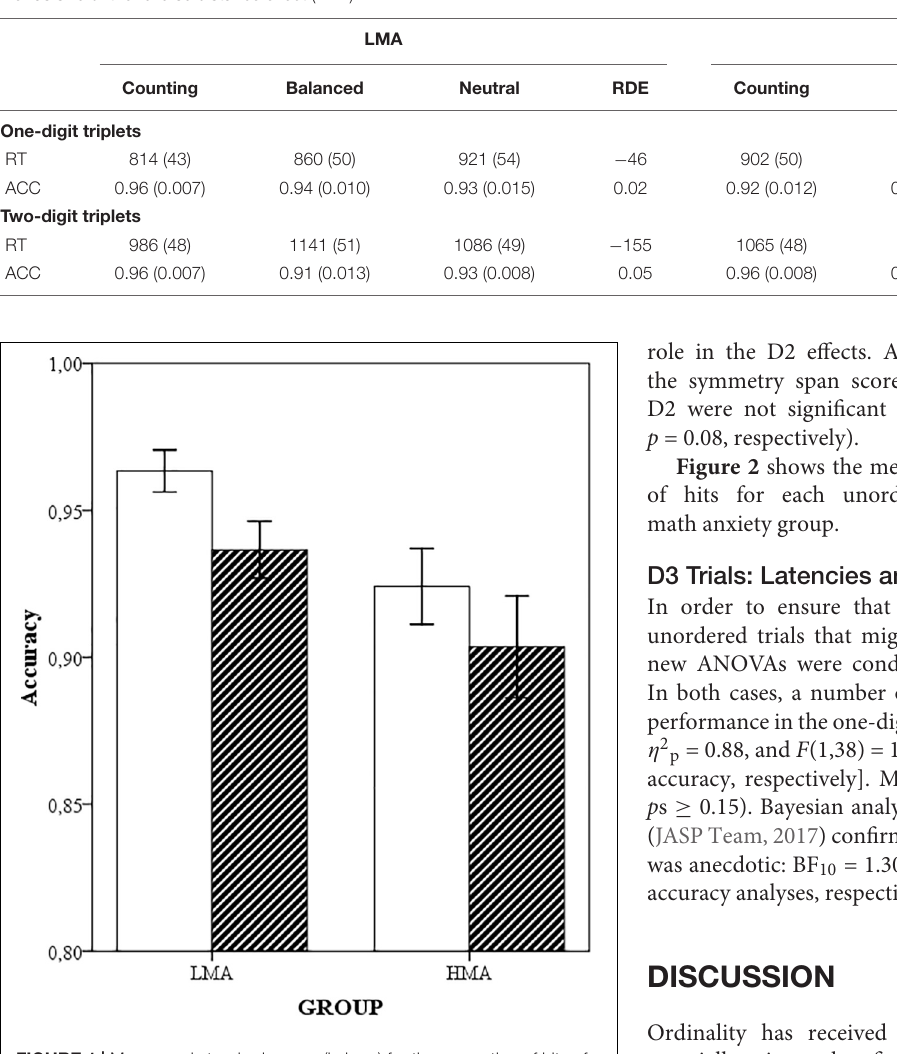
TABLE 1 | Ordered triplets: mean reaction times (RT; standard error in brackets) and accuracy (ACC) for each number of digits, condition, and math anxiety group as well as size of the reverse distance effect (RDE).